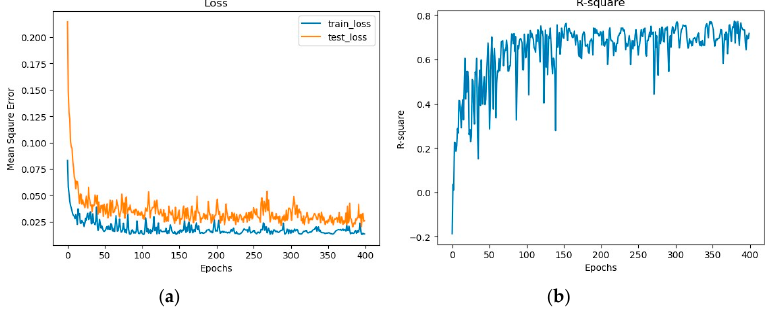
Figure 7. ( a ) Loss plot and ( b ) coefficient of determination (R-square) values for the capsule network method.